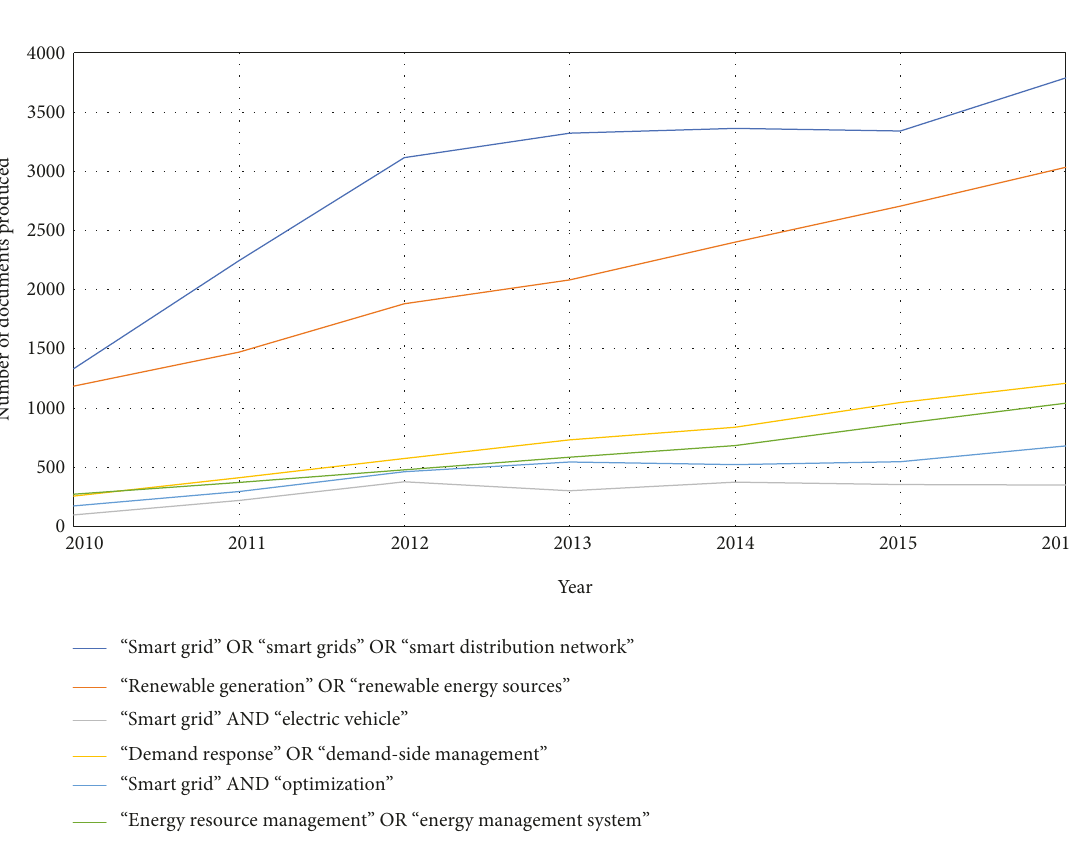
Figure 3: Documents produced between 2010 and 2016 by search term in the SCOPUS database.